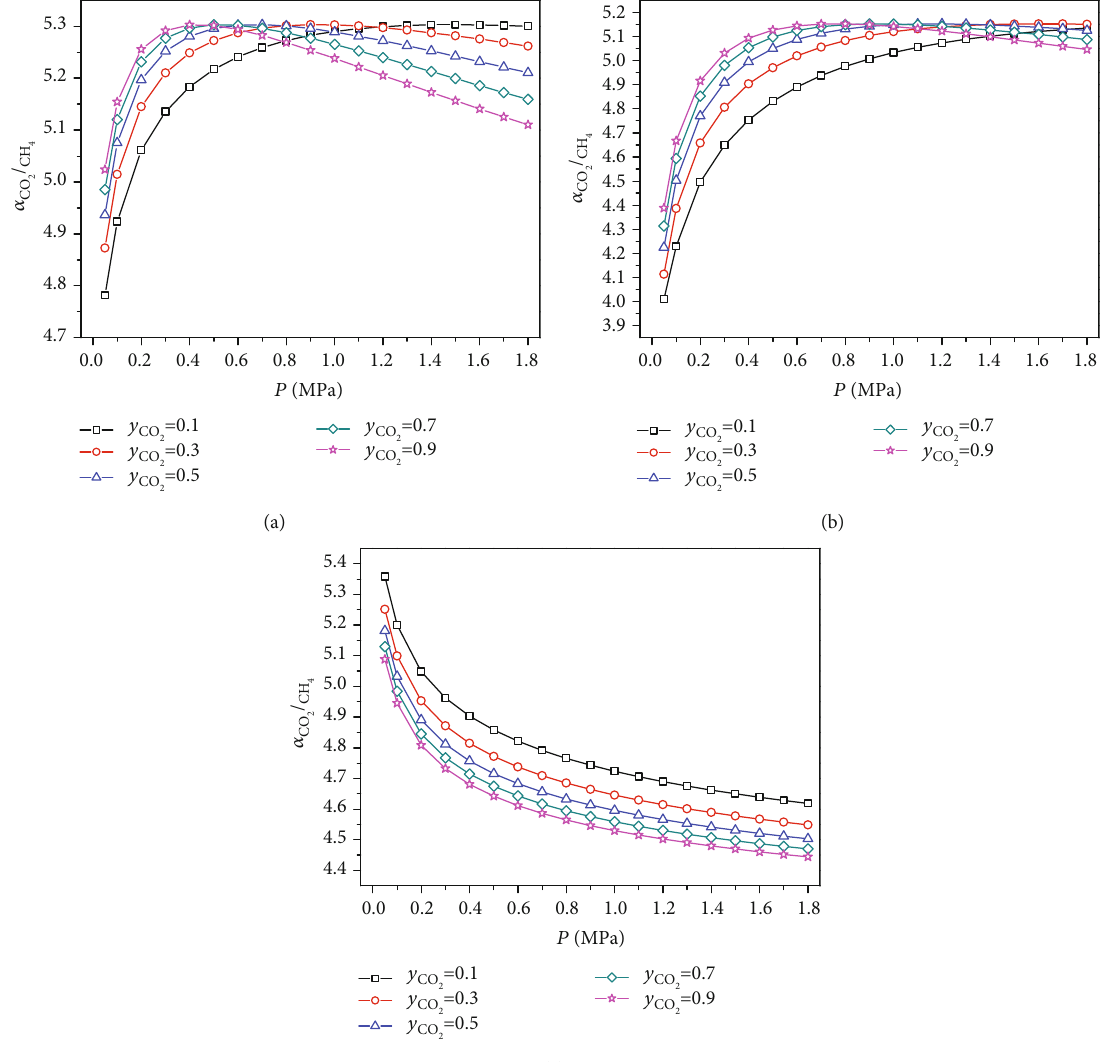
over CH at di ff erent temperatures: (a) 283K, (b) 303K, and (c) 323 2 4